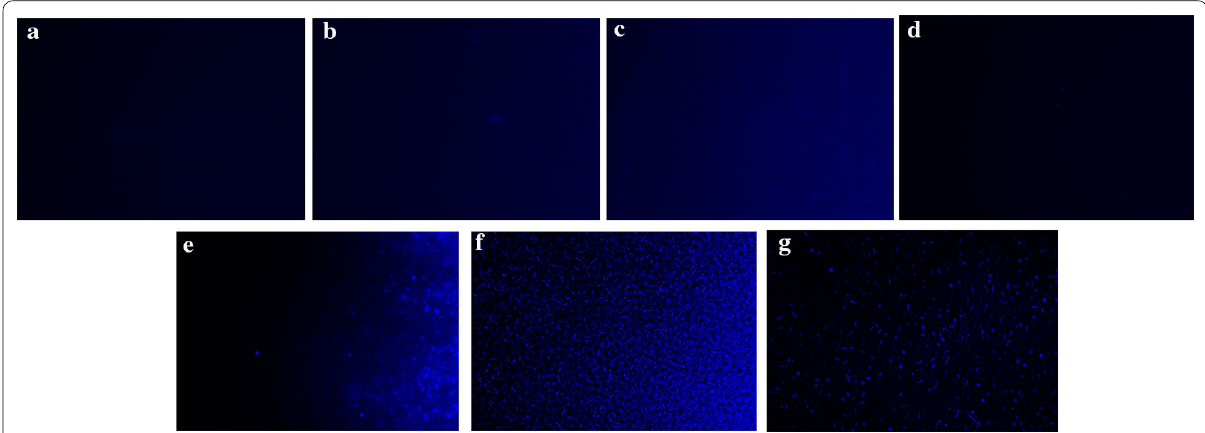
Fig. 6 Colistin accumulation is enhanced in the presence of ursolic acid similar to CCCP. Mid log cells were incubated with colistin-dansyl chloride alone and along with ursolic acid (UR)/CCCP for 3 h and imaged using a fluorescent microscope. a Untreated, b colistin, c colistin chloride, e colistin-dansyl chloride, f colistin-dansyl chloride